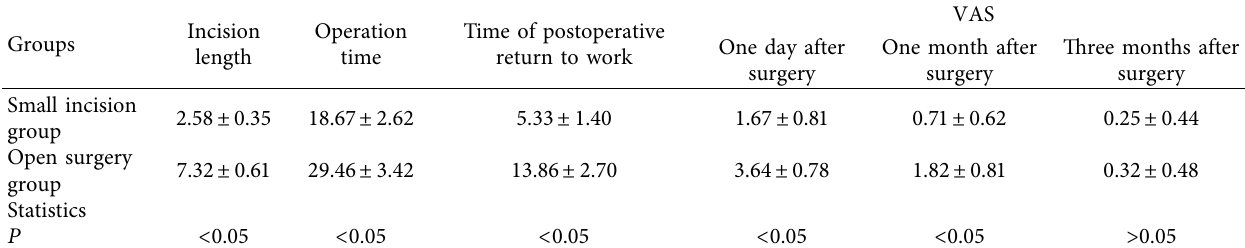
Table 2: Comparison of the intraoperative and postoperative conditions between the two groups of patients.